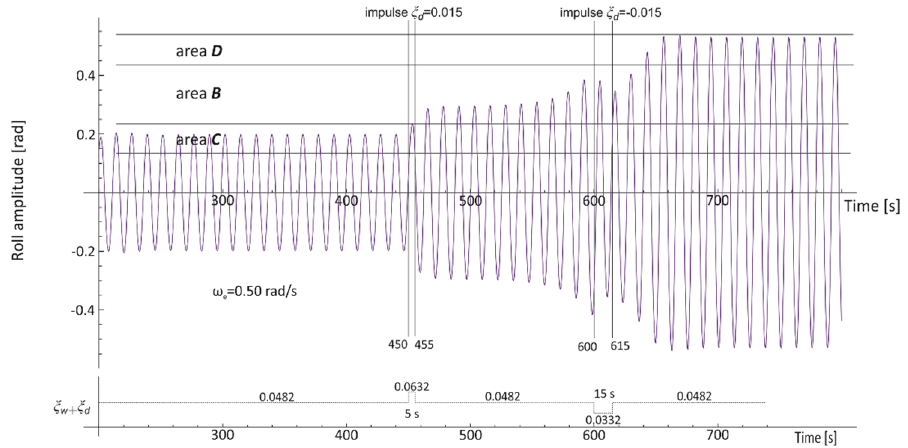
Figure 12. Roll time history for the OSV vessel ( T = 6.10 m, GM 0 = 2.50 m, ξ w = 0.0482). The additional exciting moments: ξ d 1 (450–455 s) = 0.015, ξ d 2 (600–615 s) = − 0.015.